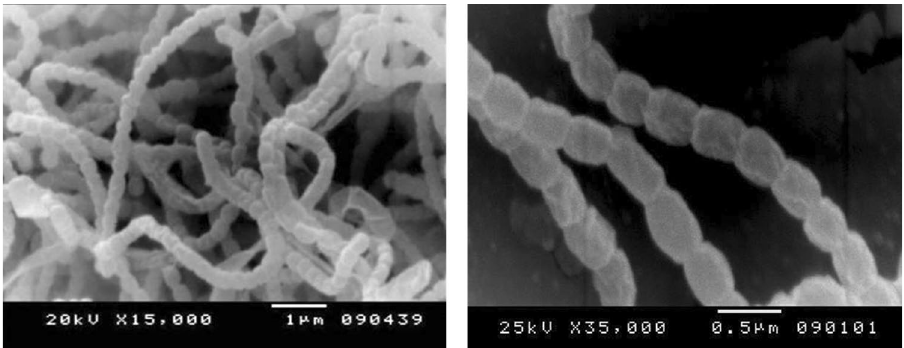
Figure 1. SEM micrographs showing the spore-chain morphology of the marine Actinomycete isolate S. rochei